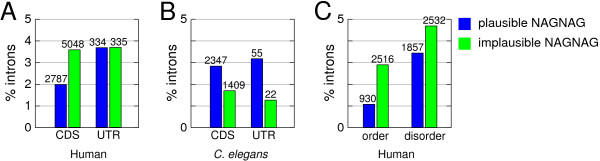
Distribution of plausible and implausible NAGNAG acceptors. (A) Human and (B) C. elegans UTR vs. CDS introns; (C) Human CDS introns divided into a location in ordered or disordered regions. Each bar is the percentage of introns having a plausible (blue) or implausible (green) NAGNAG acceptor. Absolute intron numbers are given above the bars.